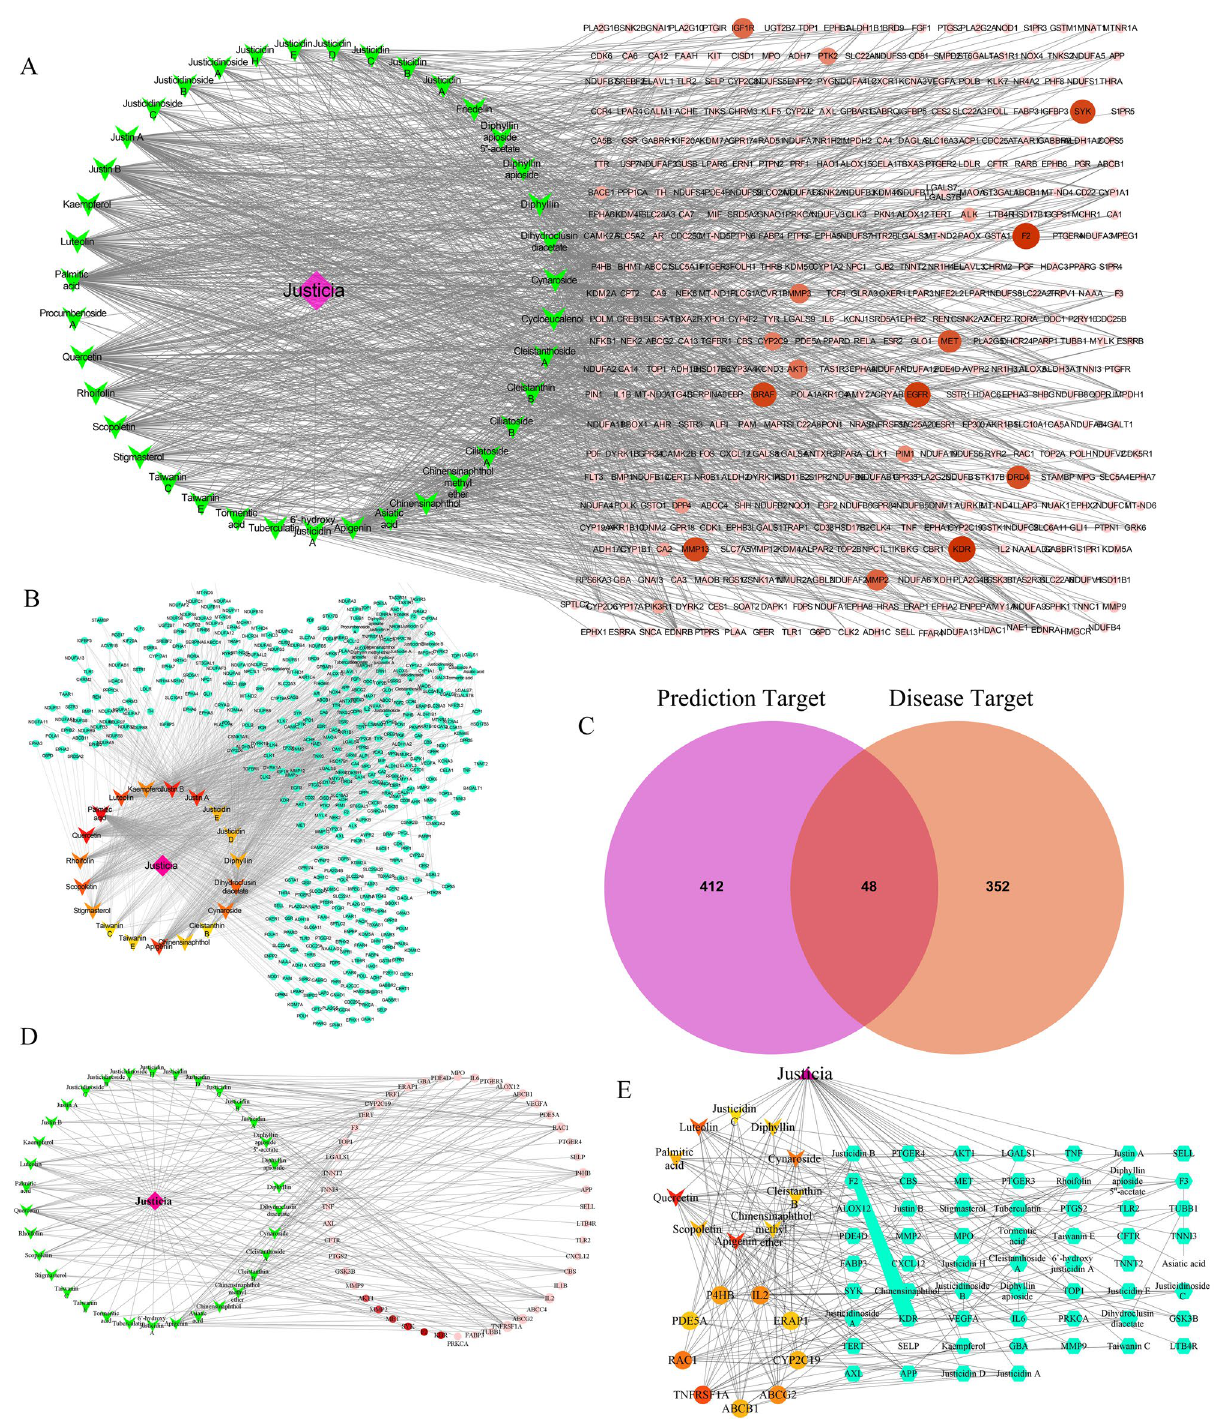
Figure 1. Constructed network related to Herb-compounds-targets. ( A ) Herb-compounds-predicted targets network. ( B ) The core components in the Herb-compound-predicted target network calculated by Cytohubba (top 20). ( C ) The intersection of justicia’s compound predicted targets and thrombus-related targets, with 48 common targets. ( D ) Herb-compounds-common targets network. ( E ) The 11 core components and 9 hub targets in the herb-compounds-common targets network calculated by Cytohubba. The purple square represents the botanical justicia, the three-pointed star represents the compound, and the circle represents the target. For the targets in ( A , D ), the darker the circle, the larger the degree. The light yellow to dark orange gradient in ( B , E ) indicates that the corresponding node is more